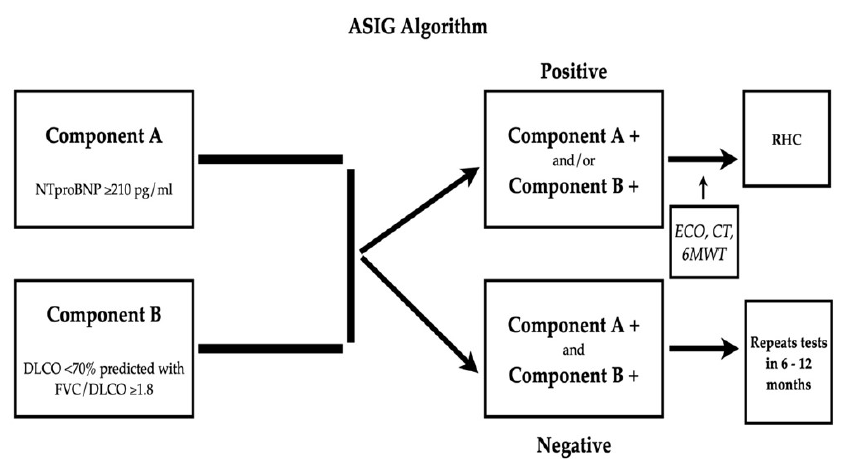
Figure 2. ASIG Algorithm. Modified after [70]. Legend: FVC forced vital capacity; DLCO diffusing capacity for carbon monoxide; NTproBNP, N-terminal pro-brain natriuretic